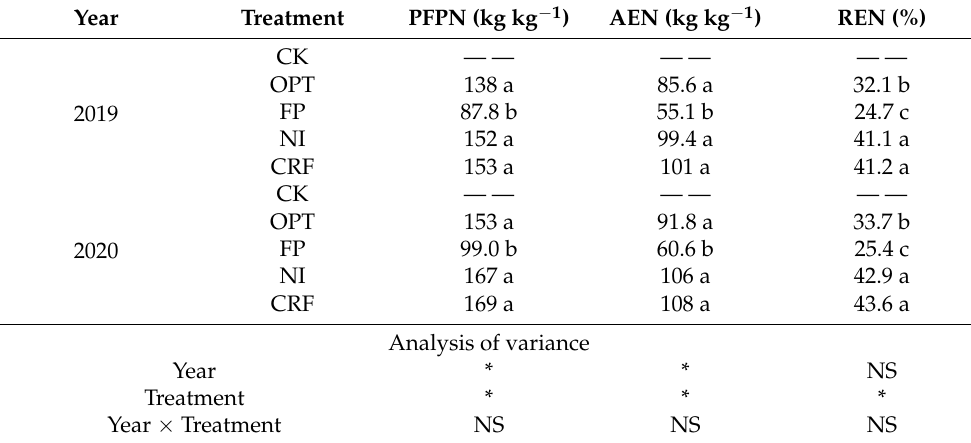
Table 2. Effects of different treatments on the N use efficiencies of pepper in 2019 and